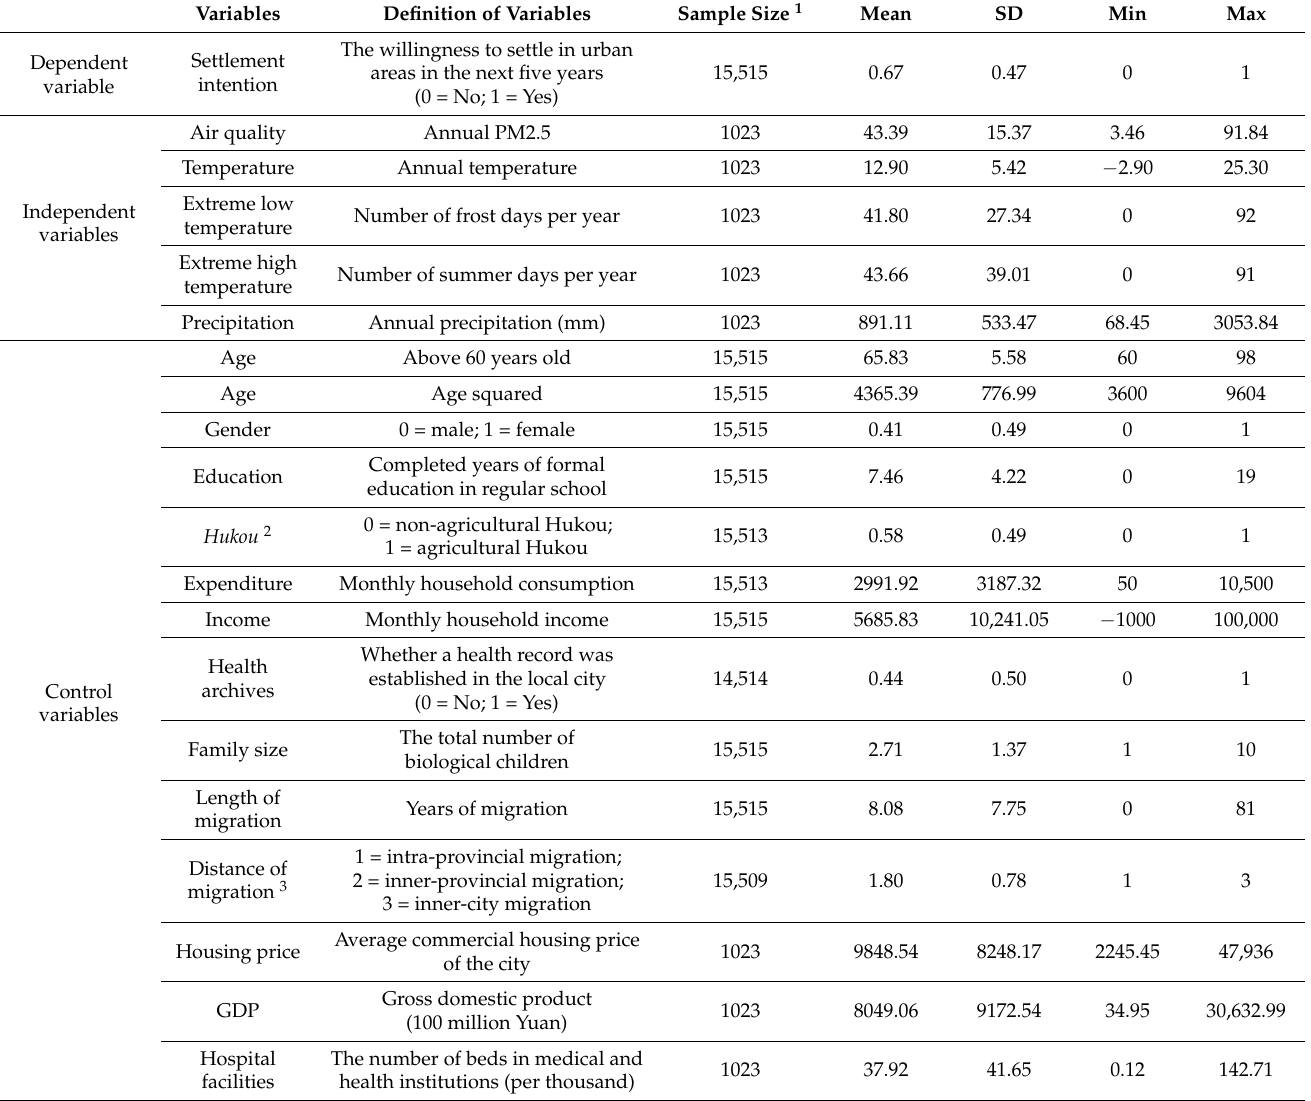
Table 1. The descriptive statistics of